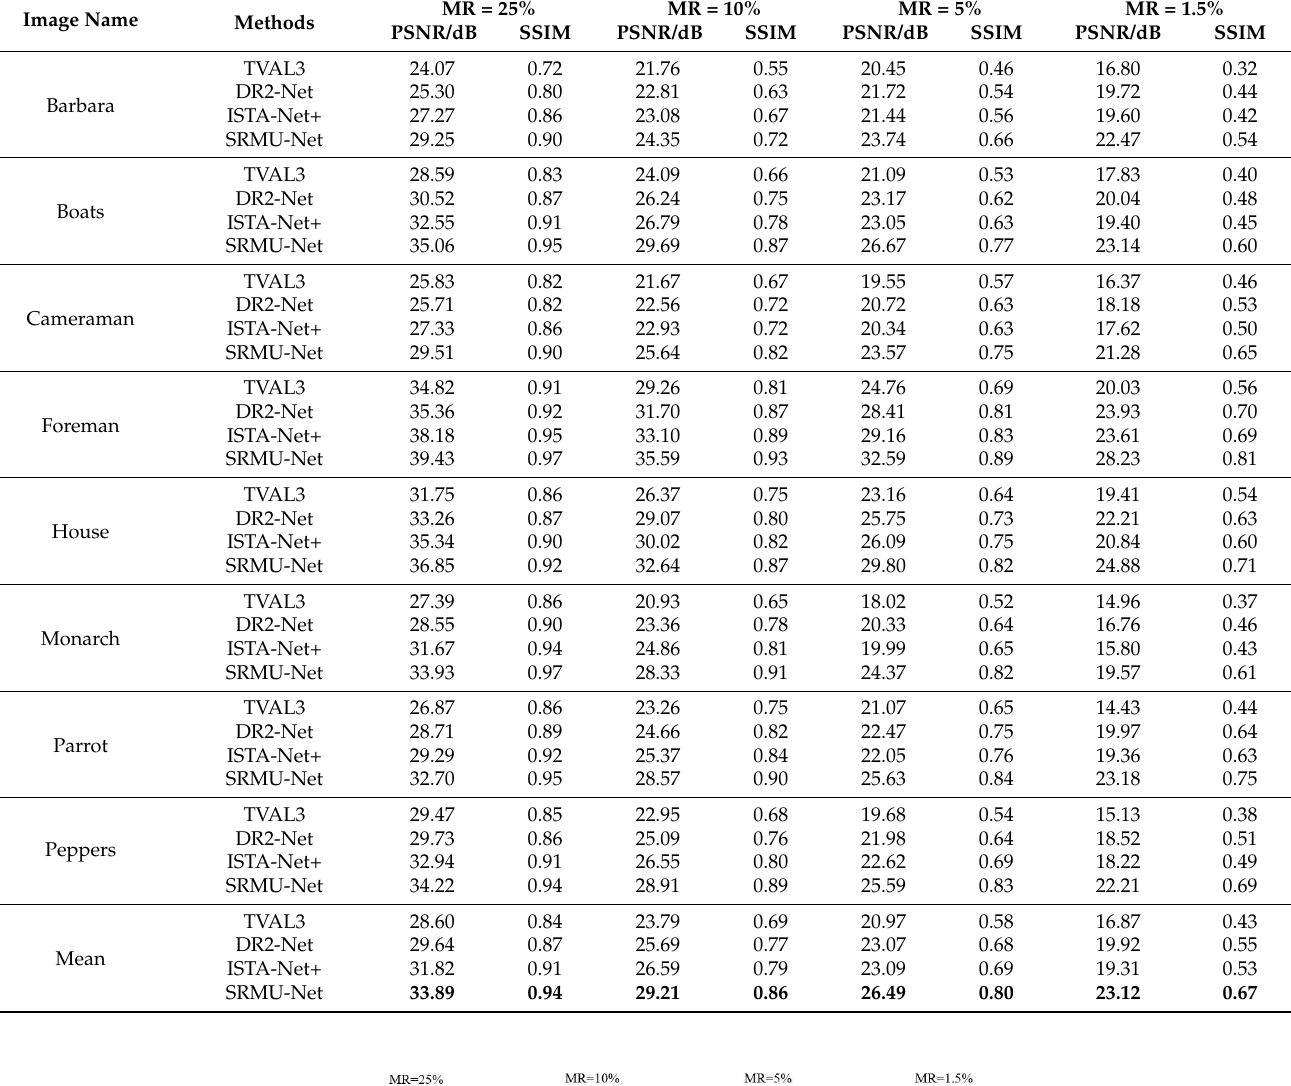
Table 3. Comparison of different algorithms’ test set performances under different MRs in terms of PSNR (dB) and SSIM. The best performance is marked in bold.